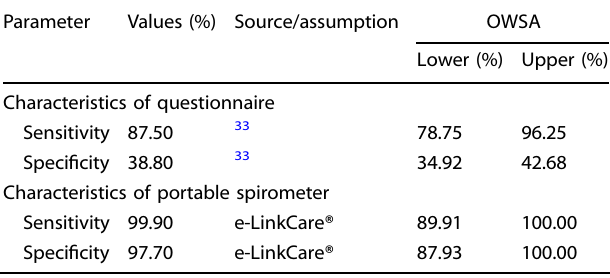
Table 2. Sensitivity and speci fi city of different screening approaches.